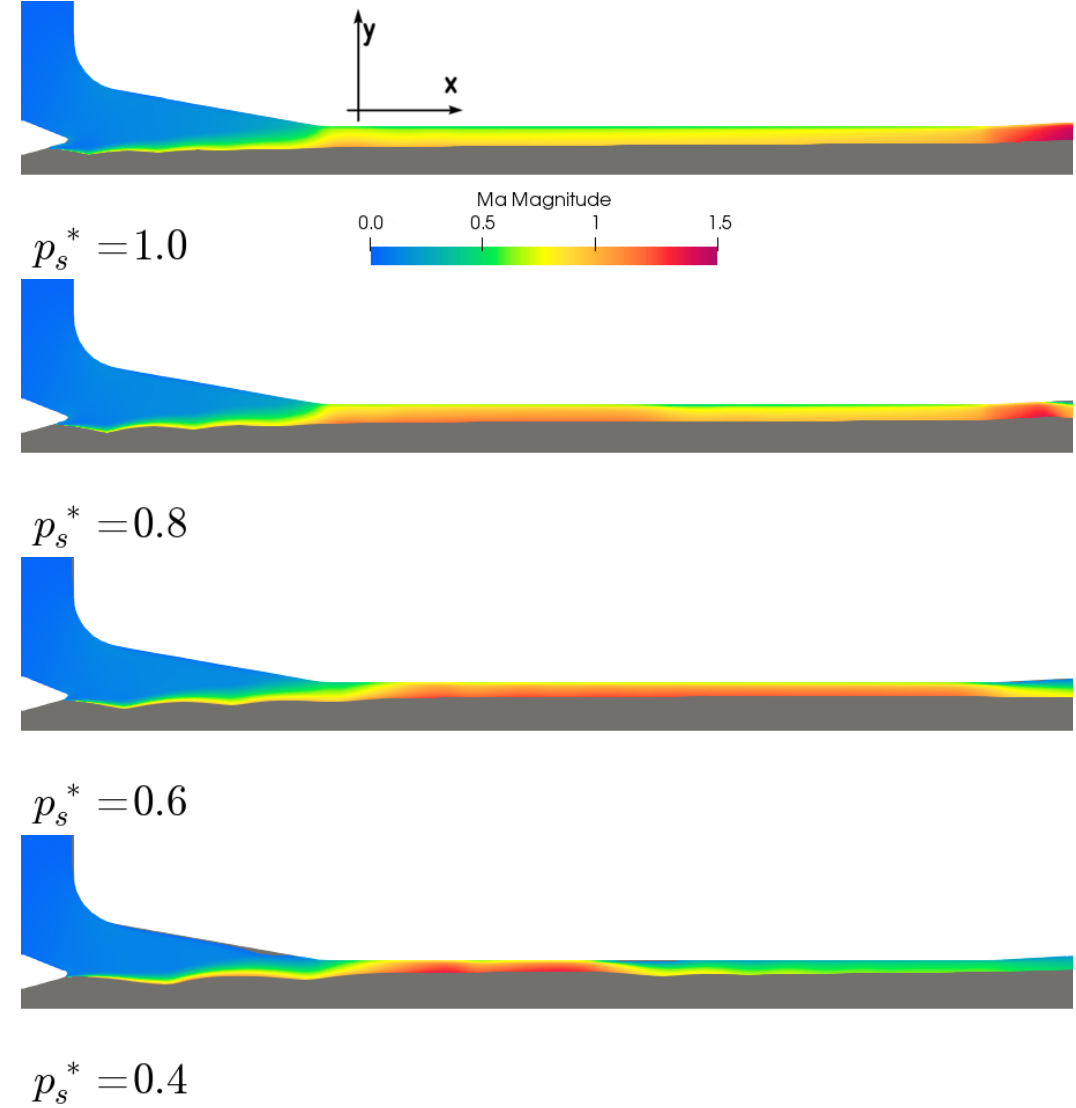
Figure 11. Secondary flow for p ∗ s ≥ 0.4. The flow direction is from the left (inlet) to the right